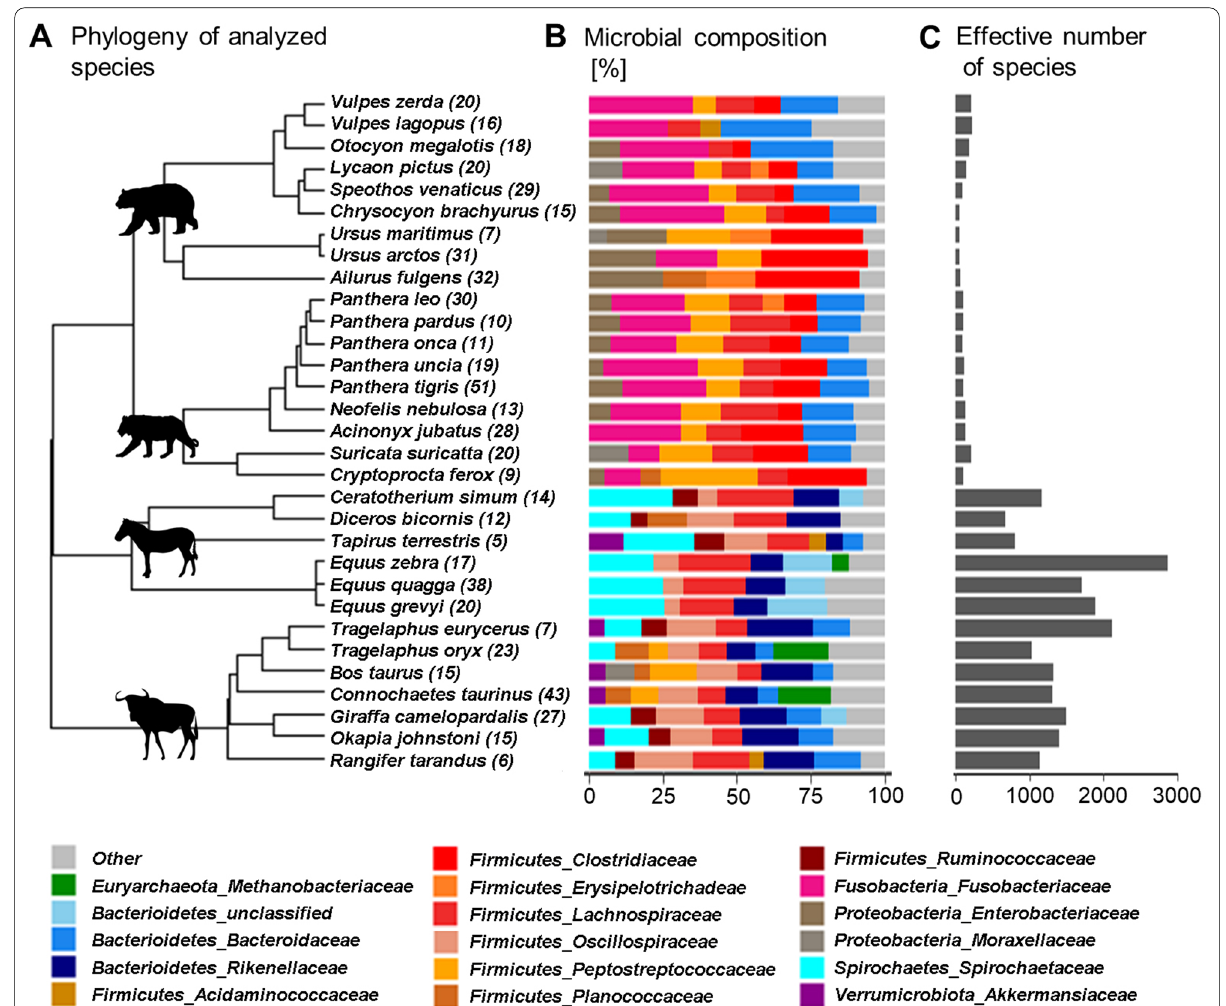
Fig. 1 Variation in the fecal microbiota of mammals. A Phylogeny of the analyzed 31 species based on TimeTree database [30]. The total number of samples per species is shown in brackets. B Average composition of the fecal microbiota per species. Microbes that occur in less than 5% are summarized under “Other “. ANOSIM on the four groups: permutations species presented as number of effective species. Kruskal–Wallis on the four groups: p < 0.01, df